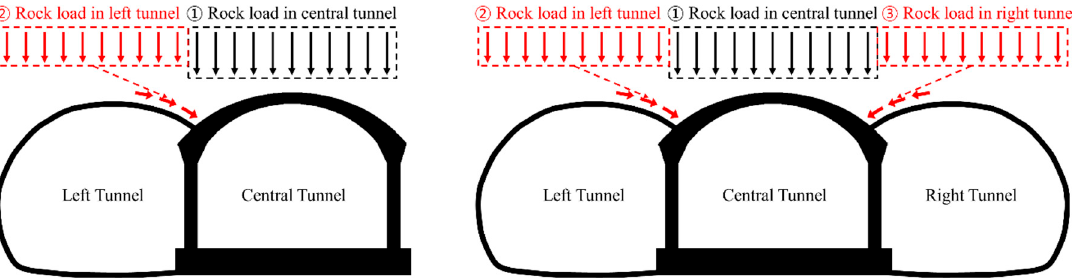
Figure 1. Mechanism of rock load development in a multi-arch tunnel.